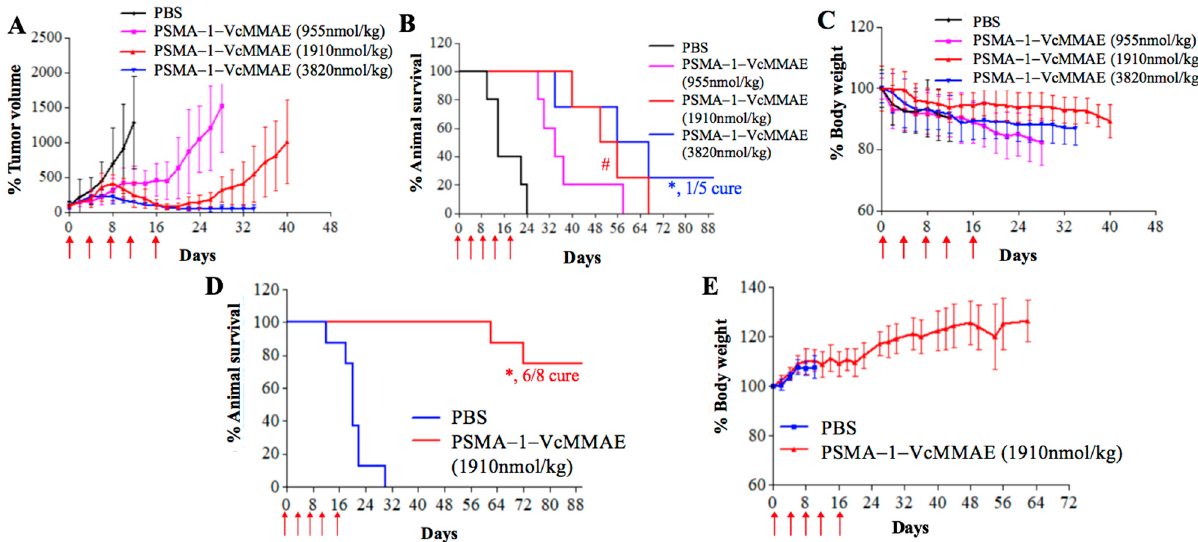
Figure 9. In vitro antitumor activity studies of PSMA-1-VcMMAE in orthotopic ( A – C ) ( n = 5) and metastatic tumor models ( D , E ) ( n = 8). Mice received drug through tail vein injection. Treatments were scheduled every 4 days with a total of five doses as indicated by the red arrow. ( A ) Orthotopic PC3pip tumor growth curves of mice treated with PSMA-1-VcMMAE. Each group had five mice. Values are mean ± SD of five animals. The plots stopped when animals died during the experiments since values are represent as mean ± SD of five animals. ( B ) Kaplan–Meier survival curves of mice bearing orthotopic PC3pip tumor. (#, 1910 nmol/kg vs. PBS, p = 0.0449; *, 3820 nmol/kg vs. PBS, p = 0.0019). ( C ) Body weight changes of mice treated with PSMA-1-VcMMAE. Values are mean ± SD of five animals. The plots stopped when animals died during the experiments since values are represent as mean ± SD of five animals. ( D ) Kaplan–Meier survival curves of mice bearing metastatic PC3pip tumor. (*,1910 nmol/kg vs. PBS, p = 0.0033). ( E ) Body weight changes of mice bearing metastatic PC3pip tumor treated with PSMA-1-VcMMAE. Values are mean ± SD of eight animals. The plots stopped when animals died during the experiments since values are represent as mean ± SD of eight animals.